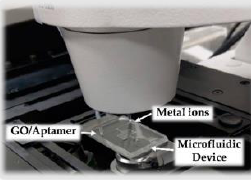
( c ) Figure 32. ( a ) Microdroplet channel layout for the SERS detection of mercury(II) ions; ( b ) SERS signal change for the microdroplets measured according to aptamer DNA release from the nanoparticle surface in the presence of mercury(II) ions, forming a stable T-Hg 2+ -T mediated hairpin structure; ( c ) Peak intensity ratios (1585 (Cy3)/489(PDMS)) as a function of mercury(II) concentration [119]. Koki Yoshida et al. used the microflow system in order to develop a DNA aptamer- linked hydrogel biochemical sensor, which allowed for repeatable detection of Ag + ions [120] (Figure 33). This is an interesting and uncommon approach to developing a device based on biological molecules’ interaction with its analyte. As the molecular receptor, the appropriate aptamer sequence was used (Figure 33a). After its interaction with Ag + , its con- formation changed. As the aptamer was embedded in hydrogel (Figure 33b), whose shape also depends on the shape of the aptamer, the overall dimensions of such hydrogel changed after its subjection to the silver ions sample (Figure 33b). The Authors also proved that the Ag + ions previously bound by aptamer could be dissociated by heating and flushing through the integrated microfluidic heating device. According to the Authors, the devel- oped microfluidic device allowed for the detection of a wide range of Ag + concentrations (10 − 5 – 10 mM), which also include a toxic range for various aquatic organisms. It was also shown that the developed biochemical sensor could be used for long-term monitoring with high stability in ambient temperature and low power consumption [120].